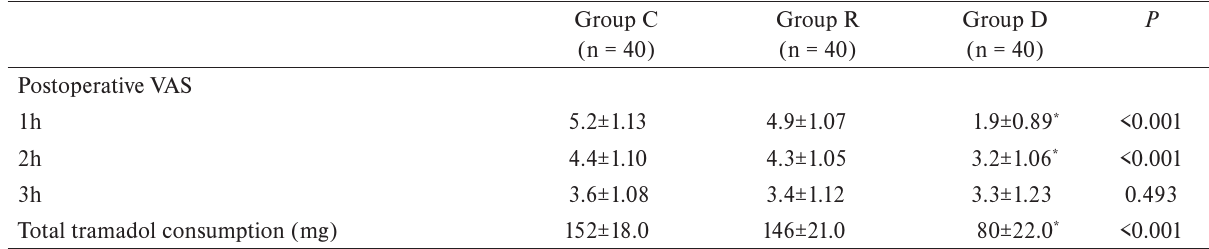
Table 2. Maternal postoperative VAS and total tramadol consumption.